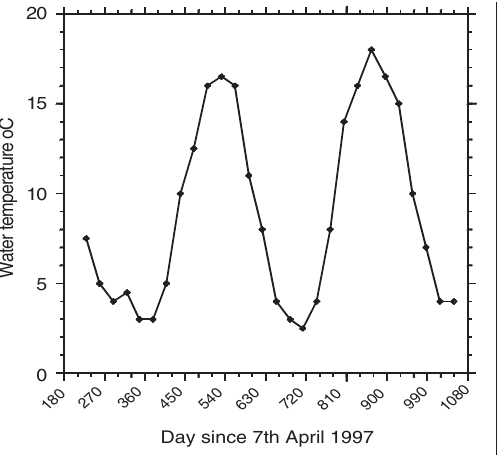
Fig. 6. Water temperature in the Kerteminde fjord between winter 1997/1998 and winter